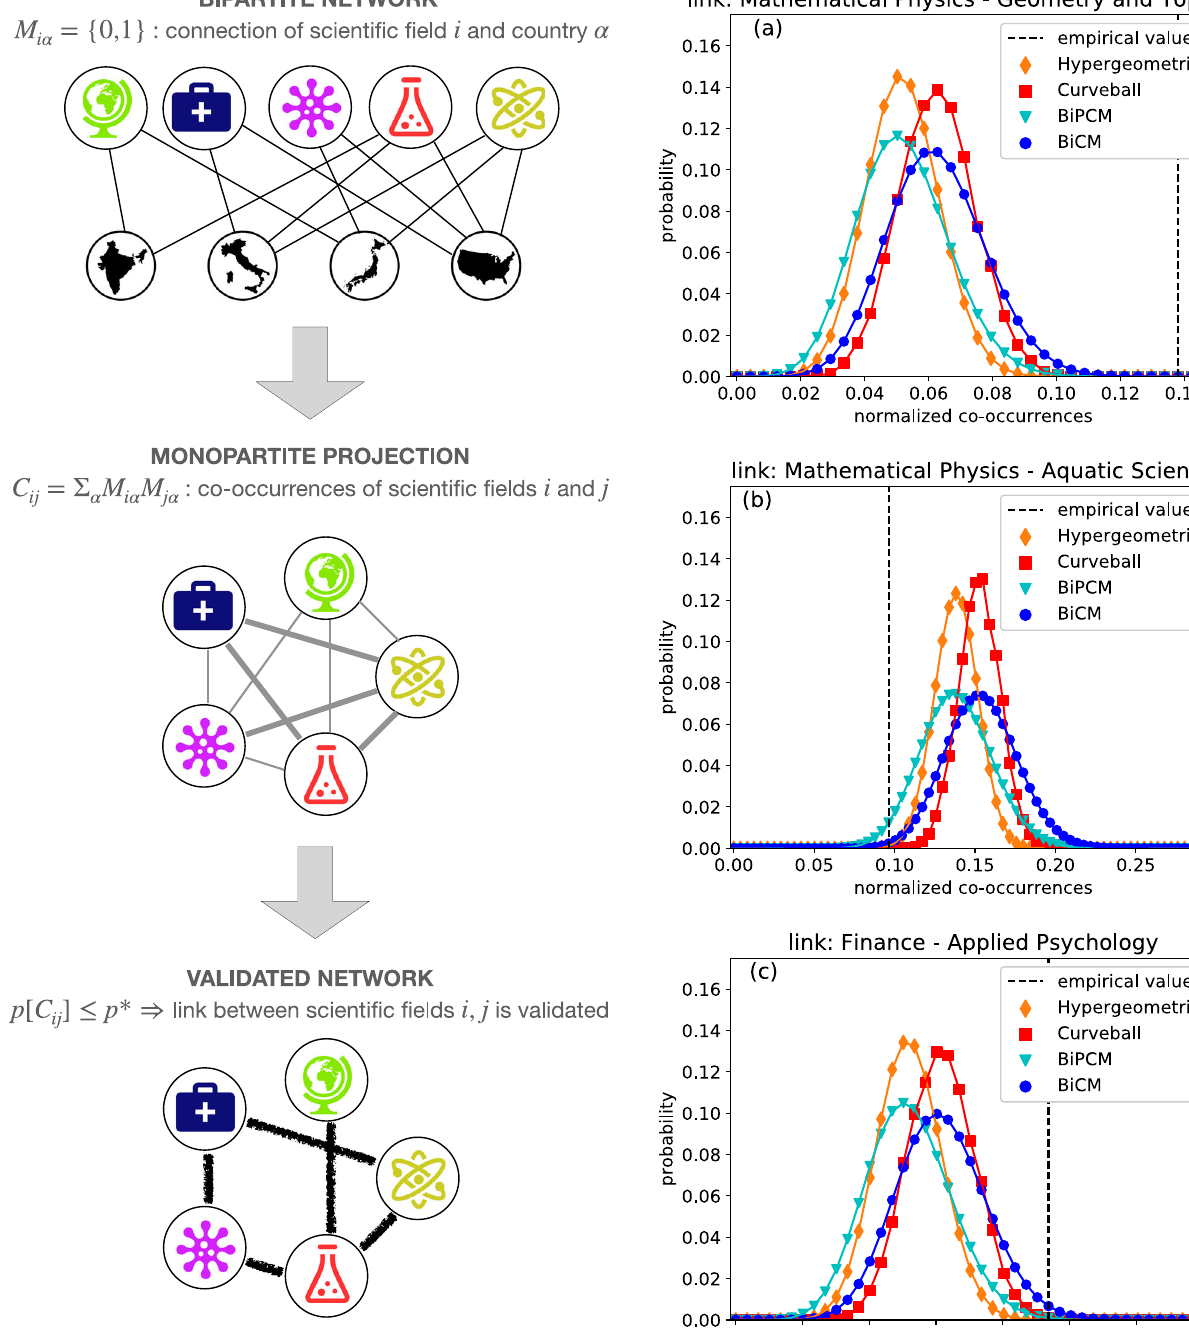
Fig. 1 Schematic illustration of the validation procedure for the bipartite network of scienti fi c fi elds and world countries. We start from the bipartite network M of scienti fi c fi elds (in this example: Earth Sciences , Medicine , Biology , Chemistry and Physics 111 ) and word countries (here: India, Italy, Japan, United States 112 ). In this network, links connect countries with the scienti fi c fi elds they have a comparative advantage on. From this bipartite structure we create a monopartite projected network C of scienti fi c fi elds, whose weighted links represent the co-occurrences of fi eld pairs in the various countries. Finally we assess the statistical signi fi cance of each observed co-occurrence against its null model expectation: we place a link on the validated network only when the p -value is smaller than the signi fi cance threshold p * . Note that this procedure is general and applies to any bipartite network.